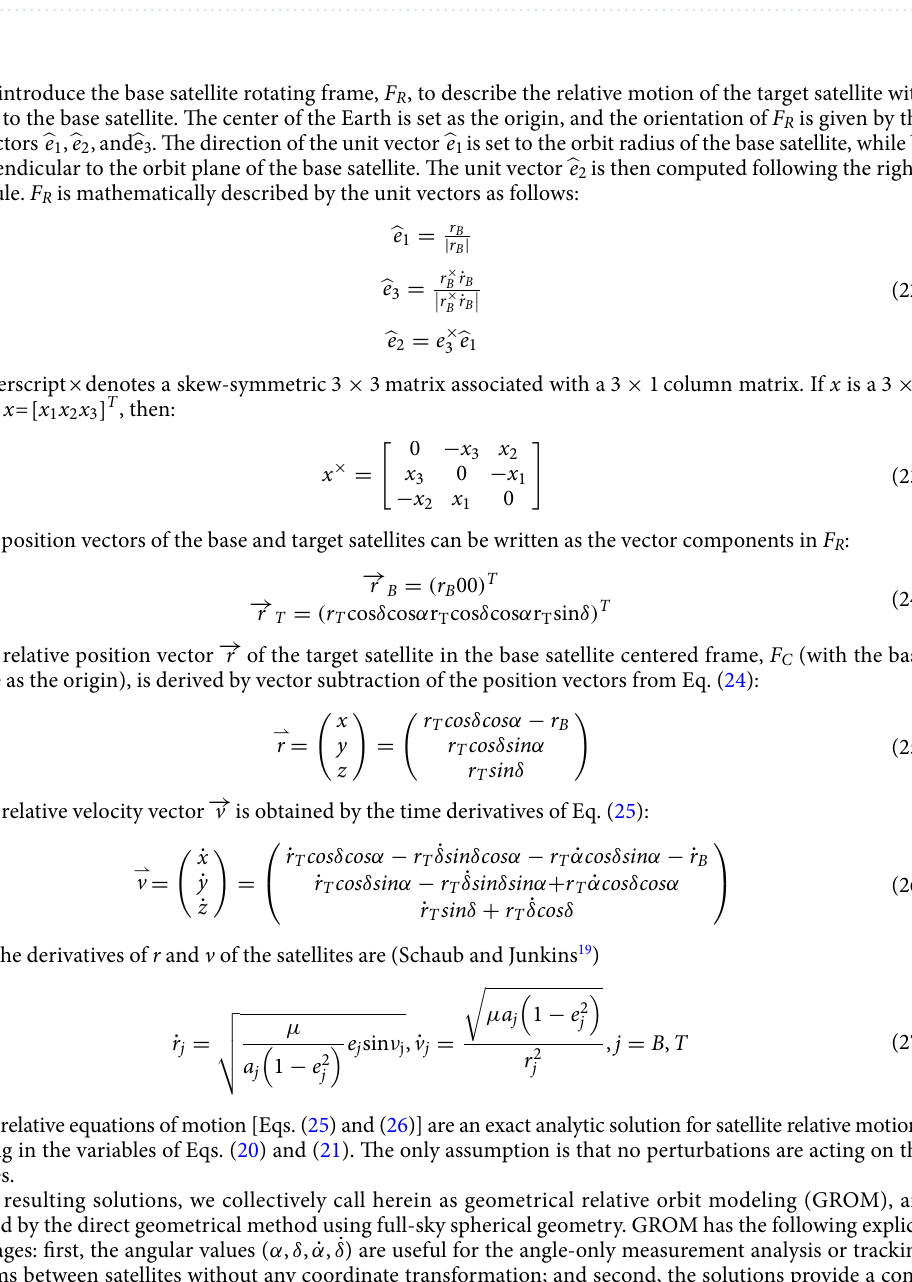
Table 1. Formula complexity of the two